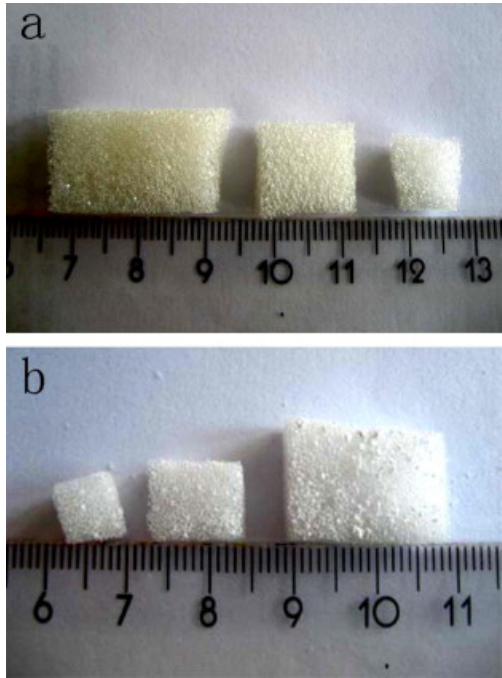
Figure 12. Photographs of ( a ) the polyurethane sponges used as macroporous templates and ( b ) the resulting hierarchical MBG scaffolds [56].